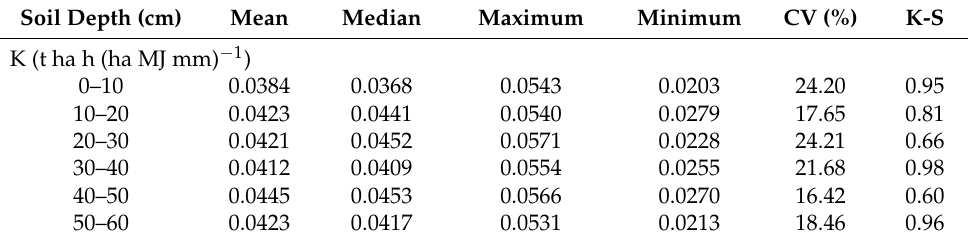
Table 1. Statistical characteristics of the K factor and Ks in different soil layers. Soil Depth